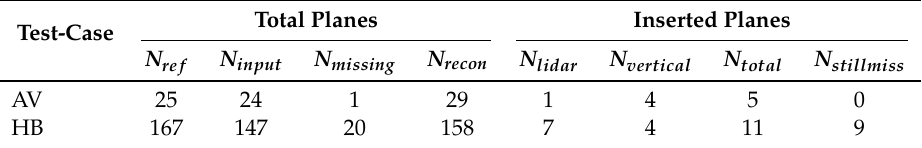
Table 2. Performance in insertion of missing planes. For all buildings in a scene, N ref is the number of reference planes, N input is the number of input planes from [9] and N missing is the number of missing planes in input plane sets. For the proposed method, N recon is the number of planes in reconstructed models, N lidar is the number of inserted LiDAR-based planes, N vertical is the number of inserted vertical planes, N total is the number of total inserted planes, and N stillmiss is the number of still missing planes. Total Planes Inserted Planes Test-Case N ref N input N missing N recon N lidar N